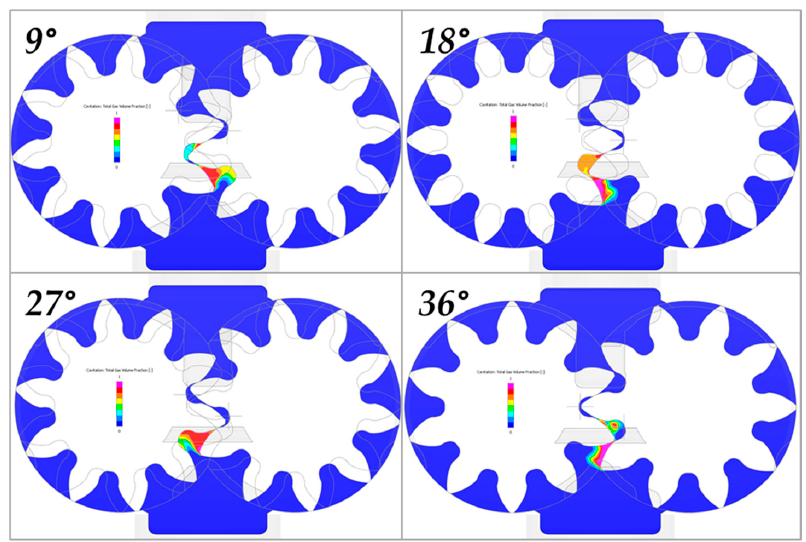
Figure 19. Distribution of the total gas fraction in a section view of the pump at 250 bar, 2500 rpm and 50 °C for a shaft rotation of θ = 9°, 18°, 27° and 36°. Areas in blue correspond to a concentration of free gas equal to zero while areas colored in